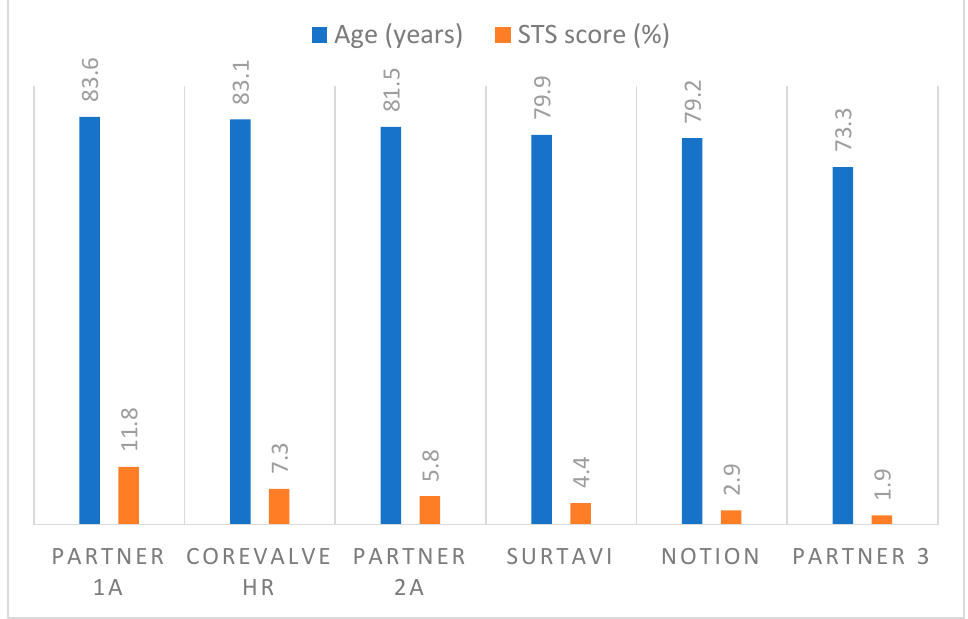
Figure 2. Studies on TAVR versus SAVR in patients at different surgical risks and of similar age. The progressive decrease in age and STS scores of patients implanted with TAVI.STS: Society of Thoracic Surgeons.